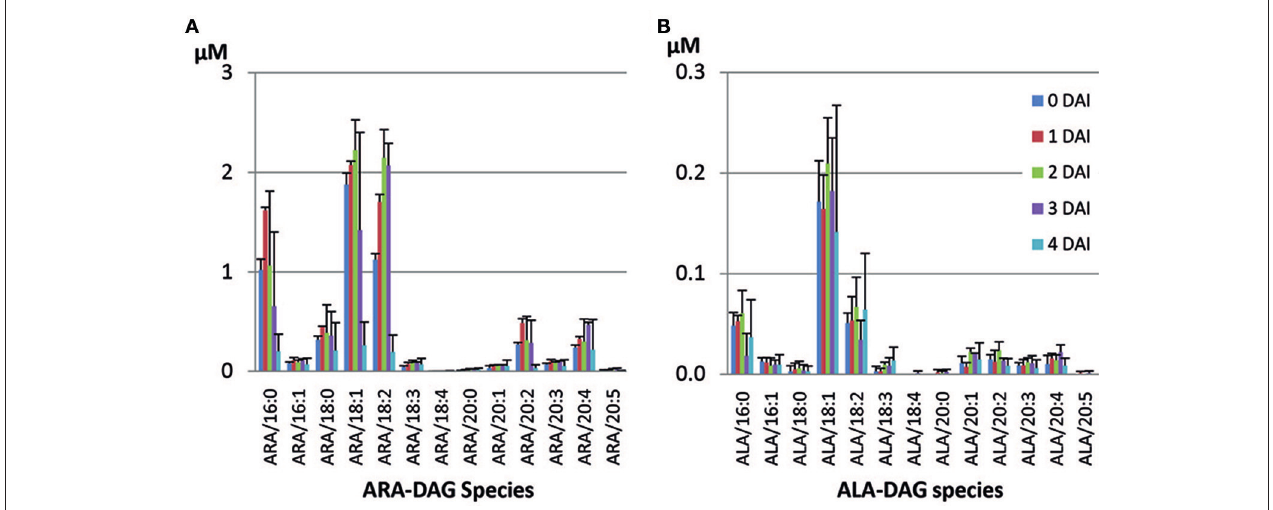
FIGURE 6 | Accumulated DAG species during seedling development in the ARA-line. (A) ARA-containing DAG species, (B) ALA-containing DAG species.